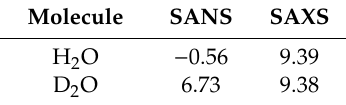
Table 2. SANS and SAXS Scattering length density [SLD] (10 10 cm − 2 ) for H 2 O and D 2 O